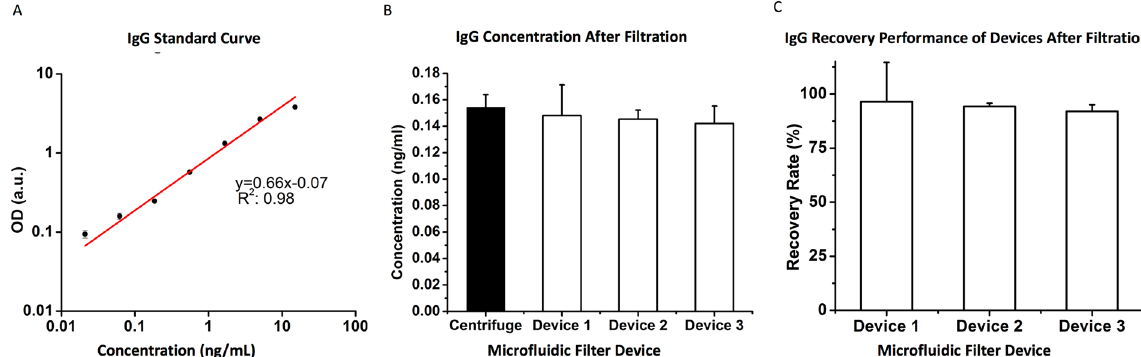
Figure 2. Evaluation of performance of microfluidic filter device using IgG proteins obtained directly from filtered whole blood. IgG in whole blood was used as a model biomarker to evaluate the performance of microfluidic device. Briefly, a commercial IgG ELISA test kit was used to detect the concentration of IgG from whole blood that was diluted 1:20 in PBS and filtered through device. As a control, same diluted blood sample was centrifuged (gold standard method) to obtain plasma. ( A ) A standard curve for IgG were generated using the standards in the commercial kit (n = 3). ( B ) After filtration via microfluidic device, the recovered IgG in whole blood was demonstrated in terms of concentration. Similarly, centrifugation results were presented in the plot. Concentrations were generated using the standard curve in Fig. 2A. There was no statistical difference between the control and microfluidic devices (n = 3, p > 0.05). ( C ) Recovery rate was calculated for microfluidic filter device. Centrifugation result was determined as 100% of recovery rate (gold standard). Average recovery rate obtained from three different microfluidic devices were calculated as 94% ± 2.0%. There is no statistical difference between the devices (n = 3, p > 0.05). Statistical analysis was performed using one way analysis of variance (ANOVA), followed by Tukey’s post hoc analysis (n = 3, p <